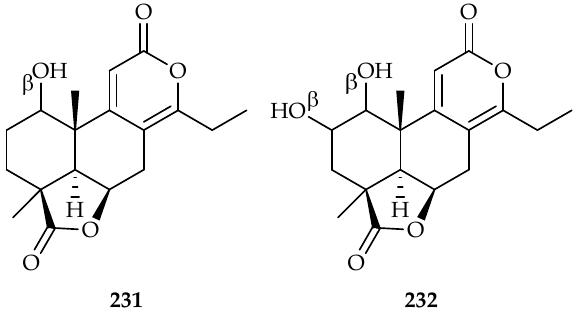
Figure 91. Structures of nagilactones L 231 [144] and 2β-hydroxynagilactone L 232 [144]. Twelve structurally related “norditerpenes”, named austrobuxusins E−M and 16- epi - austrobuxusins B, G, and H, were isolated from the EtOAc fruit extract of the species Austrobuxus carunculatus (Baill.) Airy Shaw (Picrodendraceae), a plant endemic to New Caledonia [145]. All compounds were tested against the HCT116, U87-MG (glioblastoma), and A549 cell lines. In particular, austrobuxusin F 233 and austrobuxusin L 234 showed IC 50 values of 5.8 µ M for the A549 cell line and 0.7 µ M for the U87-MG cell line, respectively. Doxorubicin was used as a positive control (Figure 92).